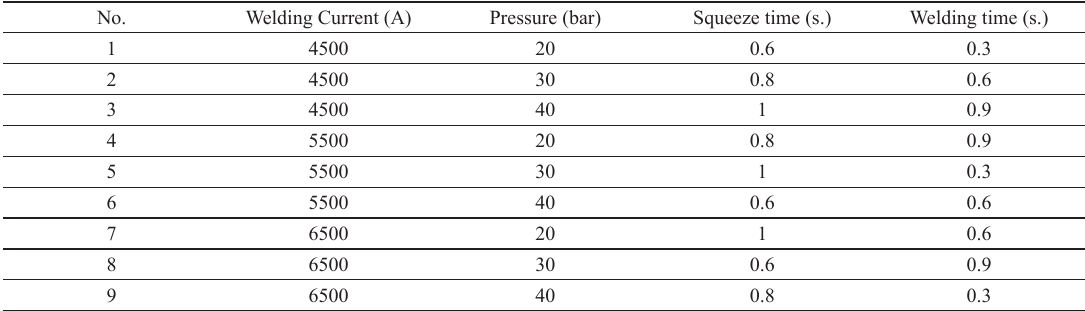
Table 3. Welding Parameter.